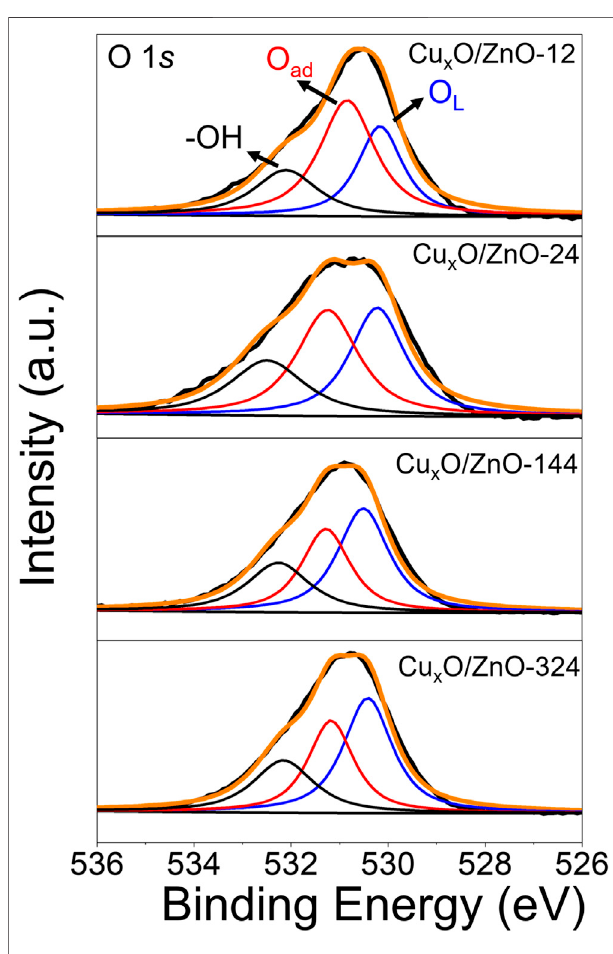
FIGURE 9 | O 1s spectra of the activated Cu condition: 300 ° C under 10% O 2 /Ar for 1